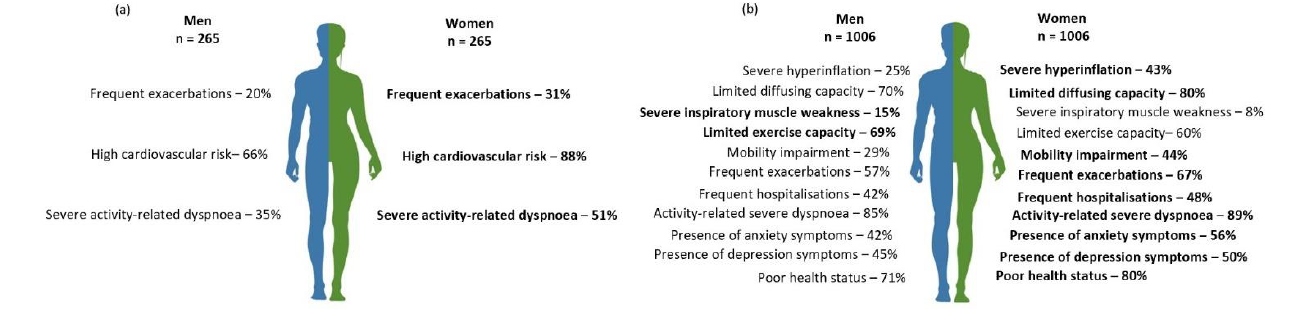
Figure 2. Prevalence of pulmonary and extra-pulmonary traits (according to the cut-offs of Table 1) that are different between women and men with chronic obstructive pulmonary disease (COPD) referred to ( a ) secondary care (n = 530) or ( b ) tertiary care (n = 2012); ( p < 0.05). Blue represents men and green represents women. Bold represents where (gender) the trait is more prevalent. There were 11 and 15 treatable traits assessed in secondary and tertiary care, respectively.